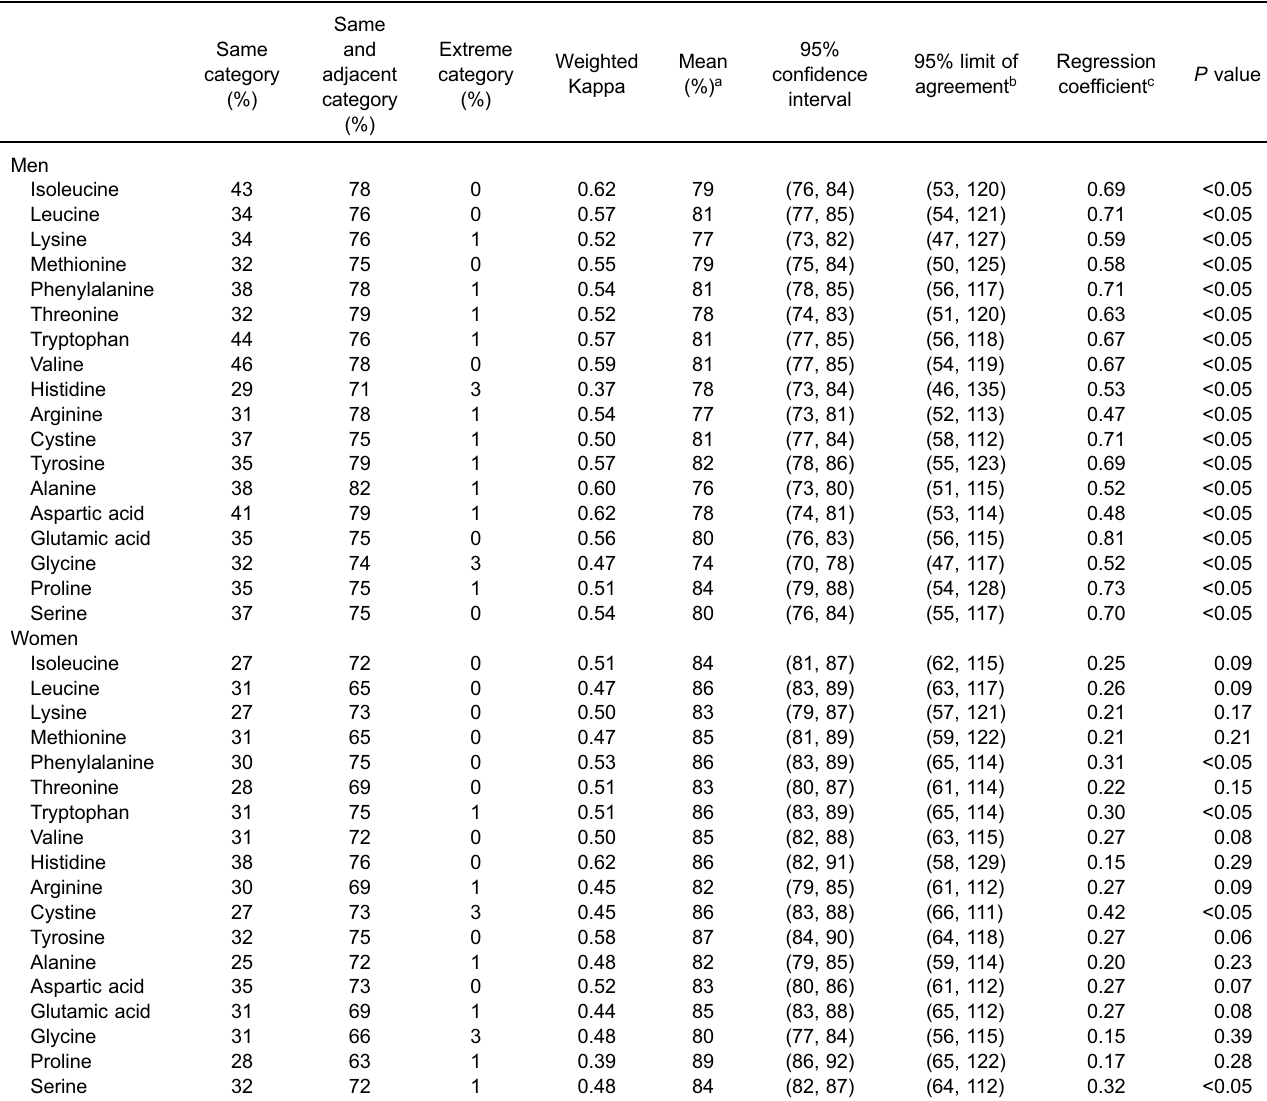
Table 6. Comparison of amino acid intake from DRs and a FFQ based on joint classi fi cation by quintile and agreement between the DR and FFQ for amino acid